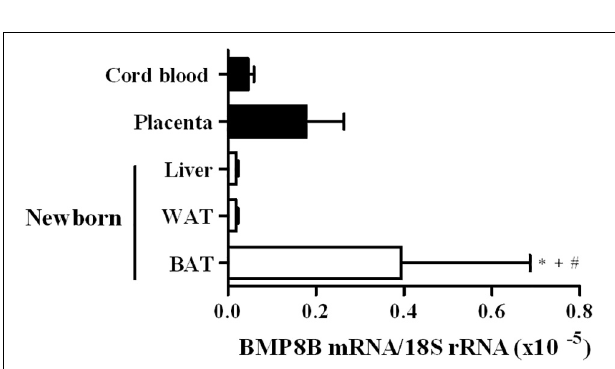
FIGURE 3 | BMP8B expression levels in brown adipose tissue (BAT, N = 5), white adipose tissue (WAT, N = 5) and liver ( N = 3) from newborns, and in placenta ( N = 4) and cord blood cells ( N = 4). Data are mean ± SEM of relative levels of BMP8B mRNA (BMP8B mRNA/18S rRNA). ∗ P = 0.031 vs. cord blood cells; + P = 0.035 vs. liver; # P = 0.007 vs.